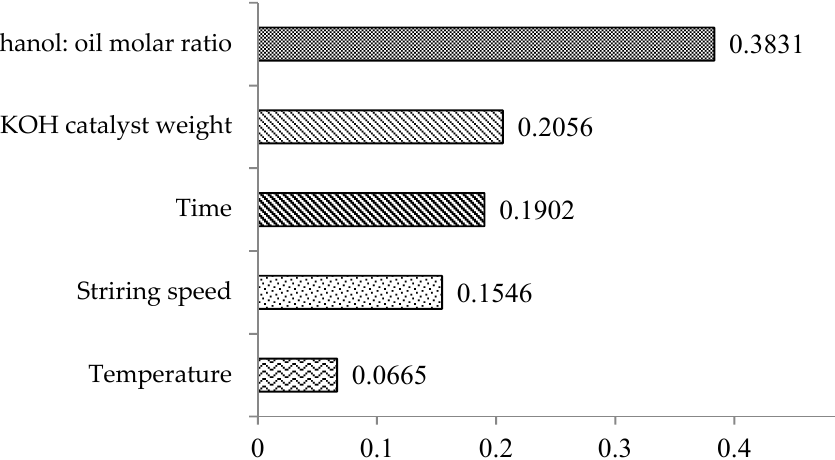
Figure 3. Relative importance of each input variable on the output variable.